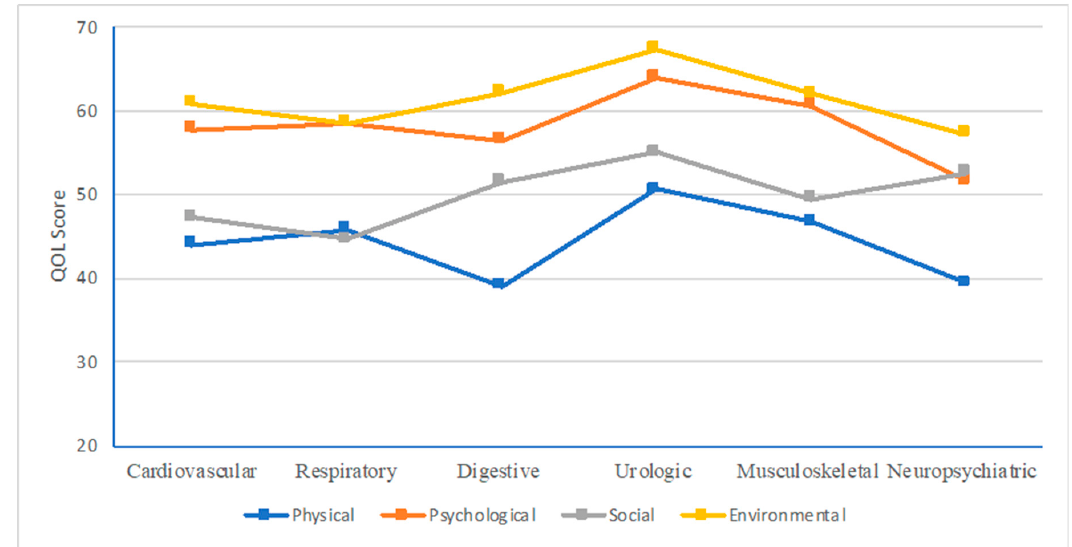
Figure 1. Correlations between diabetes duration and WHOQOL-BREF domain scores. QOL: quality of life.